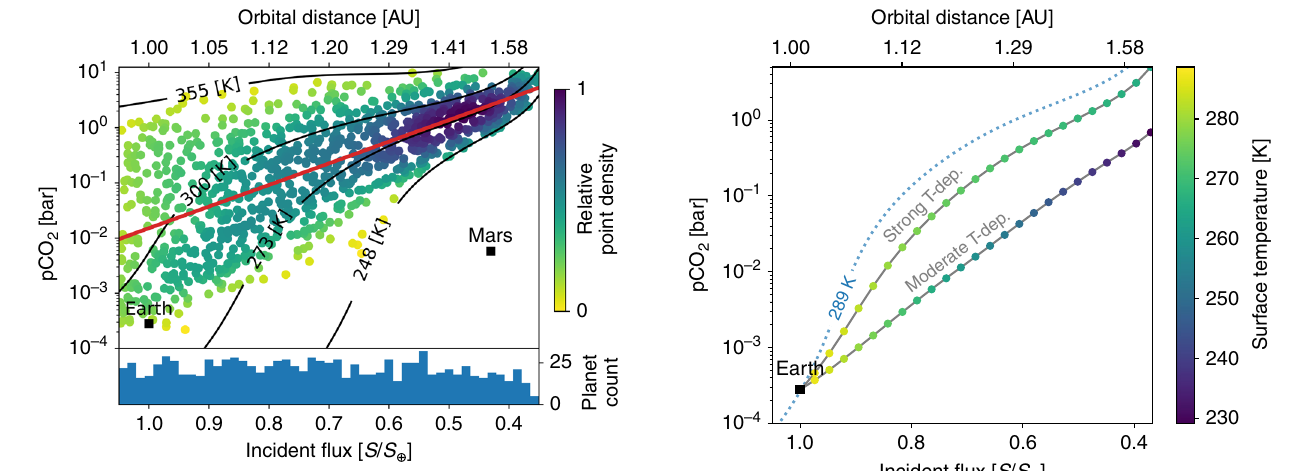
Fig. 1 The expected distribution of stable, Earth-like exoplanet climates from our habitable zone weathering model. The horizontal axis shows incident fl ux, S , normalized to the solar constant ( S ⊕ ) and the corresponding orbital distance in Astronomical Units (AU) above the plot. The vertical axis shows the atmospheric CO 2 partial pressure (pCO 2 ) in bar. Each point represents a climate in steady state. The black labeled contours show the mean global surface temperature for the given pCO 2 and incident fl ux. The white region below the 248 K contour is where our model assumption of a liquid ocean is no longer plausible so no planets are shown in that region. Above the 355 K contour, Earth-like planets are too hot to retain their liquid oceans for billions of years. Similar to the frozen planets, such hot planets are not considered habitable. Modern Earth and Mars are shown by black squares. The blue histogram at the bottom of the fi gure shows the number of stable planets in each incident fl ux bin. The color of each simulated planet shows the relative point density in the plot at that location. The color was calculated using a kernel-density estimate with Gaussian kernels and rescaled from 0 to 1. A color value of 0 represents the lowest relative point density, 1 the highest. The log-linear line of best fi t between pCO 2 and S is shown in red. The slope of the red, best fi t line is 3.92 ± 0.24 (95%) with units − log 10 (pCO 2 [bar])/( S / S ⊕ ). Our model predicts that atmospheric CO 2 should increase with orbital distance in the